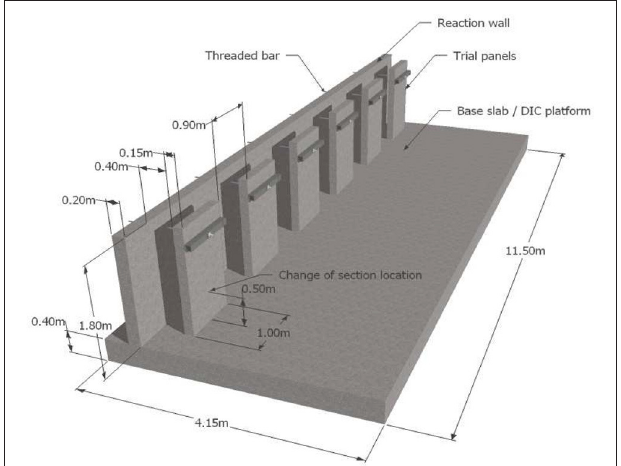
FIGURE 1 | Concept model of trial